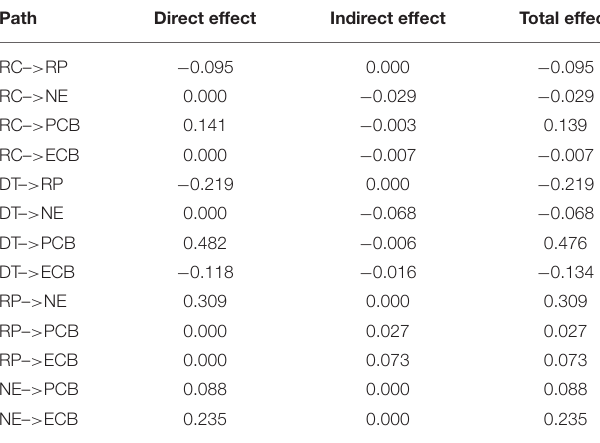
TABLE 5 | Standardized effects between variables ( β